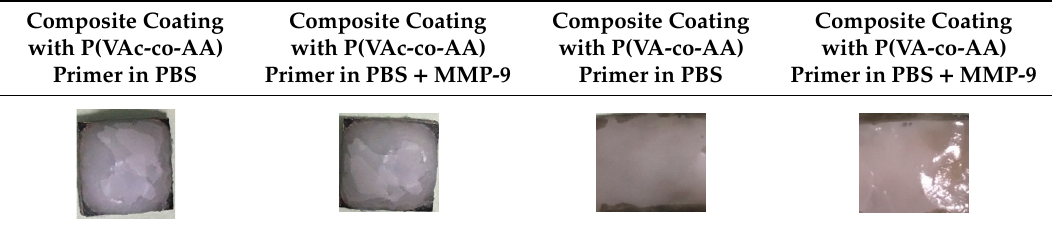
Table 2. Adhesion test for multifunctional coatings on Ti substrate in PBS, with and without MMP-9. The photos were acquired after 70 days of incubation of composite systems in an aqueous media.